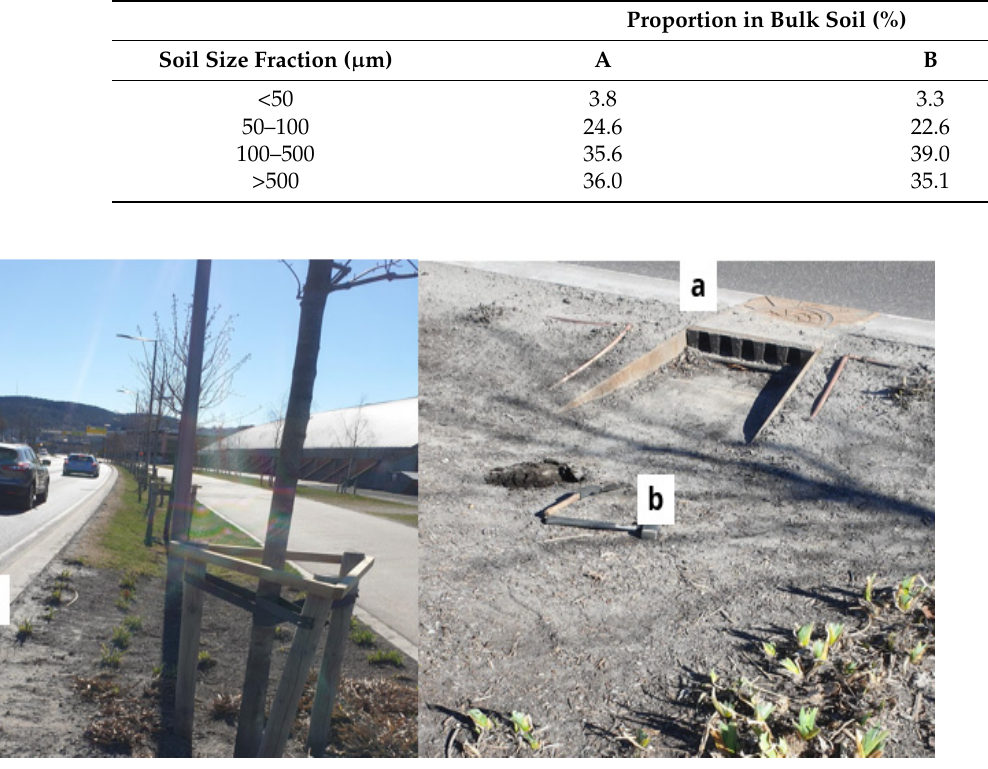
Figure 1. Left picture: the bioretention cell is the area located between the road and the sidewalk. Right picture: inlets specially designed and fitted to the side curb bring road runoff to the bioretention cell. A 13 cm high side curb (a) separates the road from the bioretention cell. Sampling spot in front of an inlet